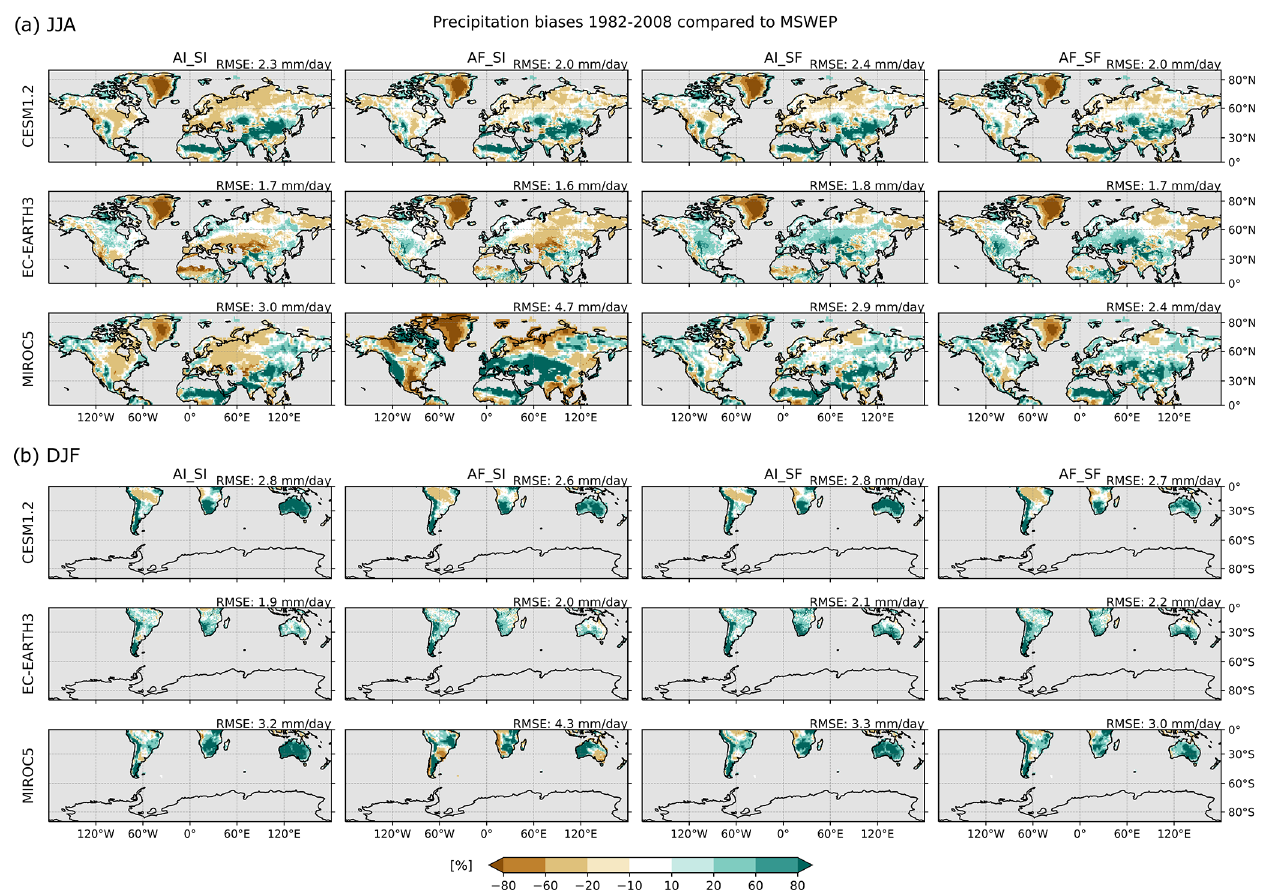
Figure A6. Same as Fig. 5 but using MSWEP as a reference data set.